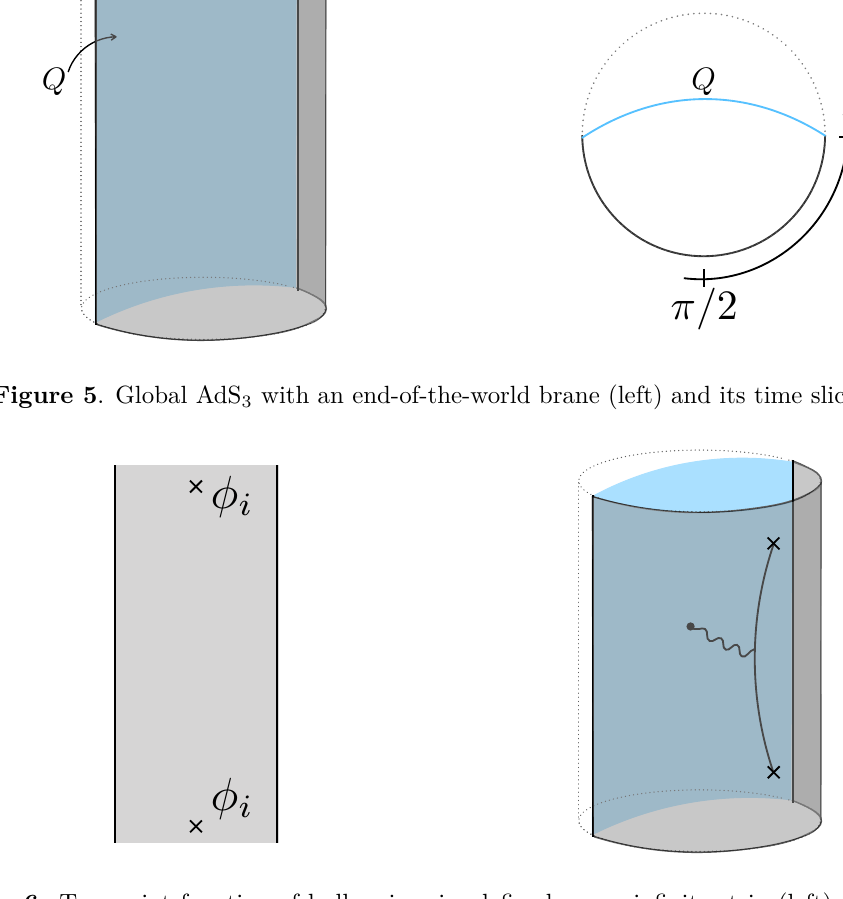
Figure 6 . Two point function of bulk primaries defined on an infinite strip (left) and its gravity dual (right). For convenience, we depict the primary insertions at finite points in these pictures. The primary insertions introduce a massive particle (solid black curve) in the gravity dual, which interacts with the brane (shown in blue). The interaction between the massive particle and the brane is schematically depicted as a wave